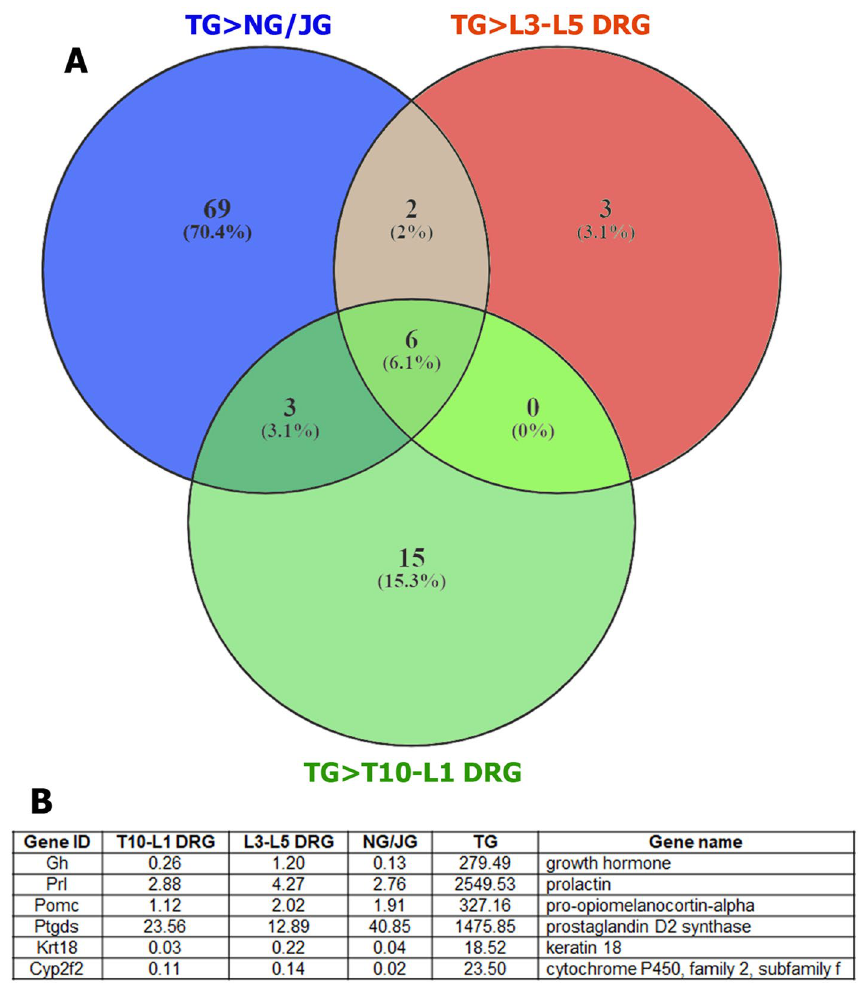
6 genes in sensory neurons isolated from different ganglia. N = 4 for each